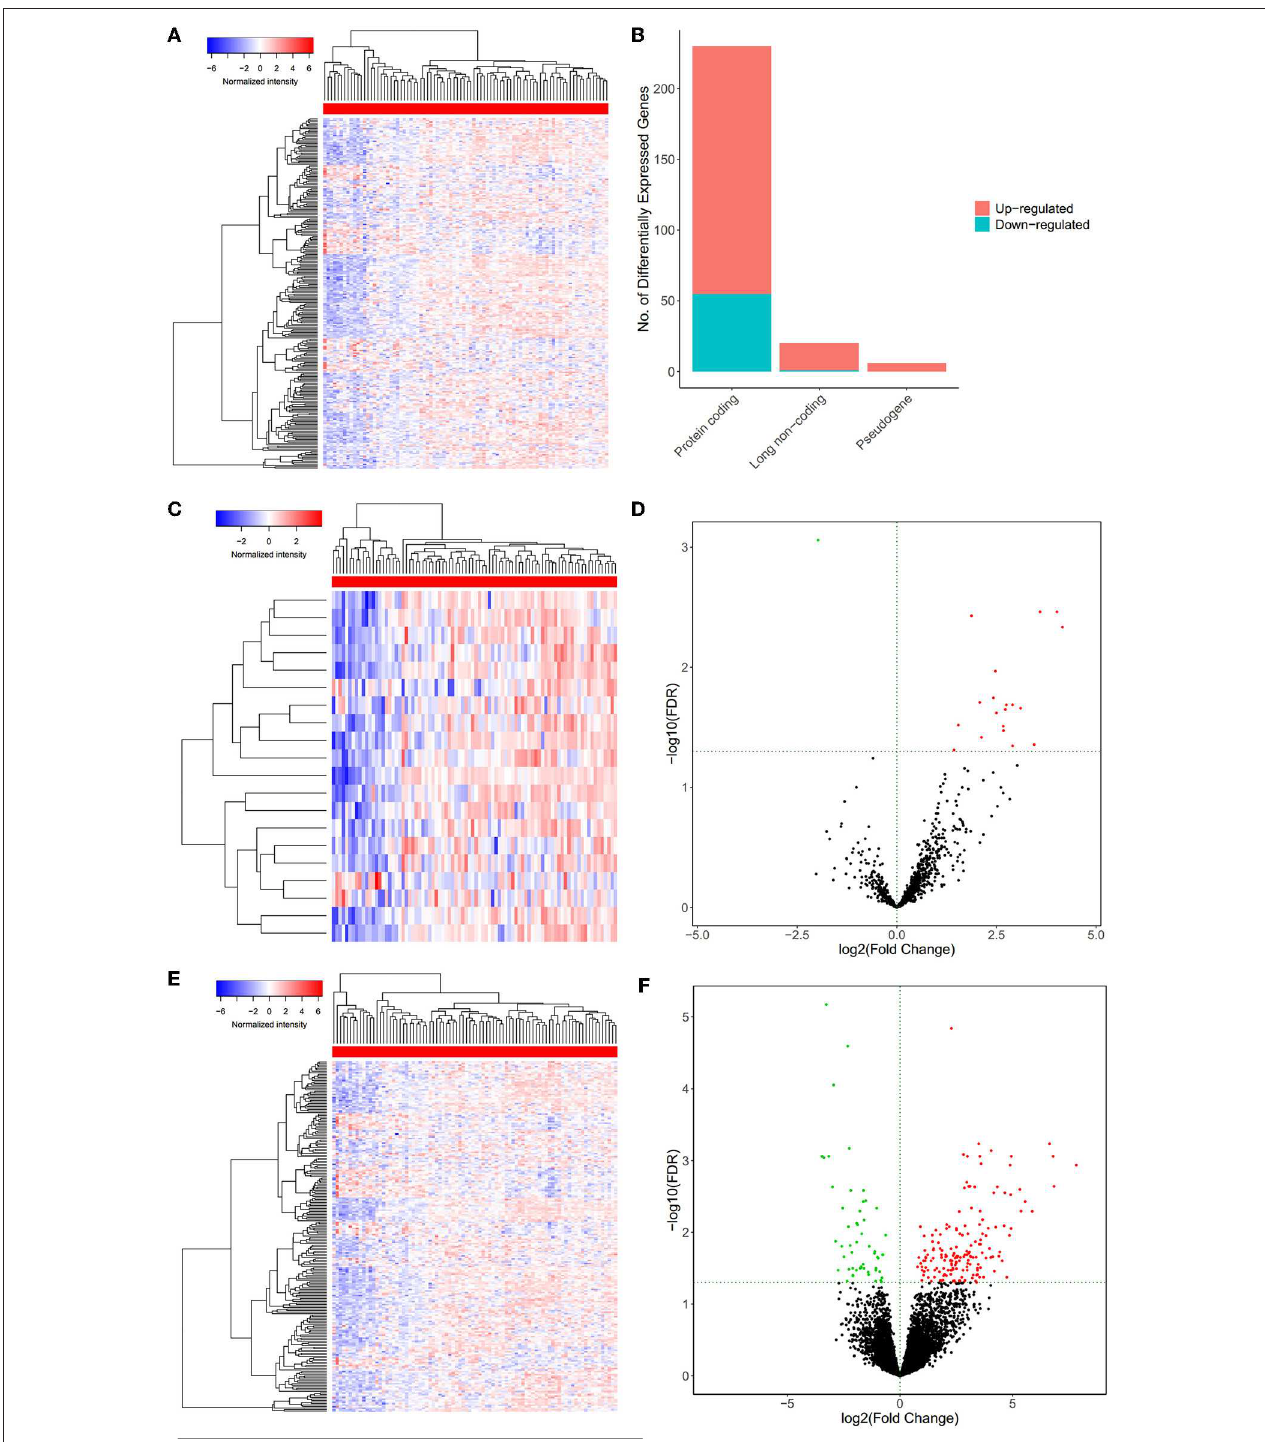
FIGURE 2 | The differentially expressed messenger RNAs (mRNAs) between primary mesothelioma and bone metastasis mesothelioma. The heatmap of differentially expressed mRNAs between primary mesothelioma and bone metastasis (A) ; the composition of differentially expressed genes (B) ; the heatmap (C); and the volcano Plot (D) of differentially expressed protein-coding genes between primary mesothelioma and bone metastasis; the heatmap (E); and the volcano Plot (F) of differentially lncRNAs between primary mesothelioma and bone metastasis.